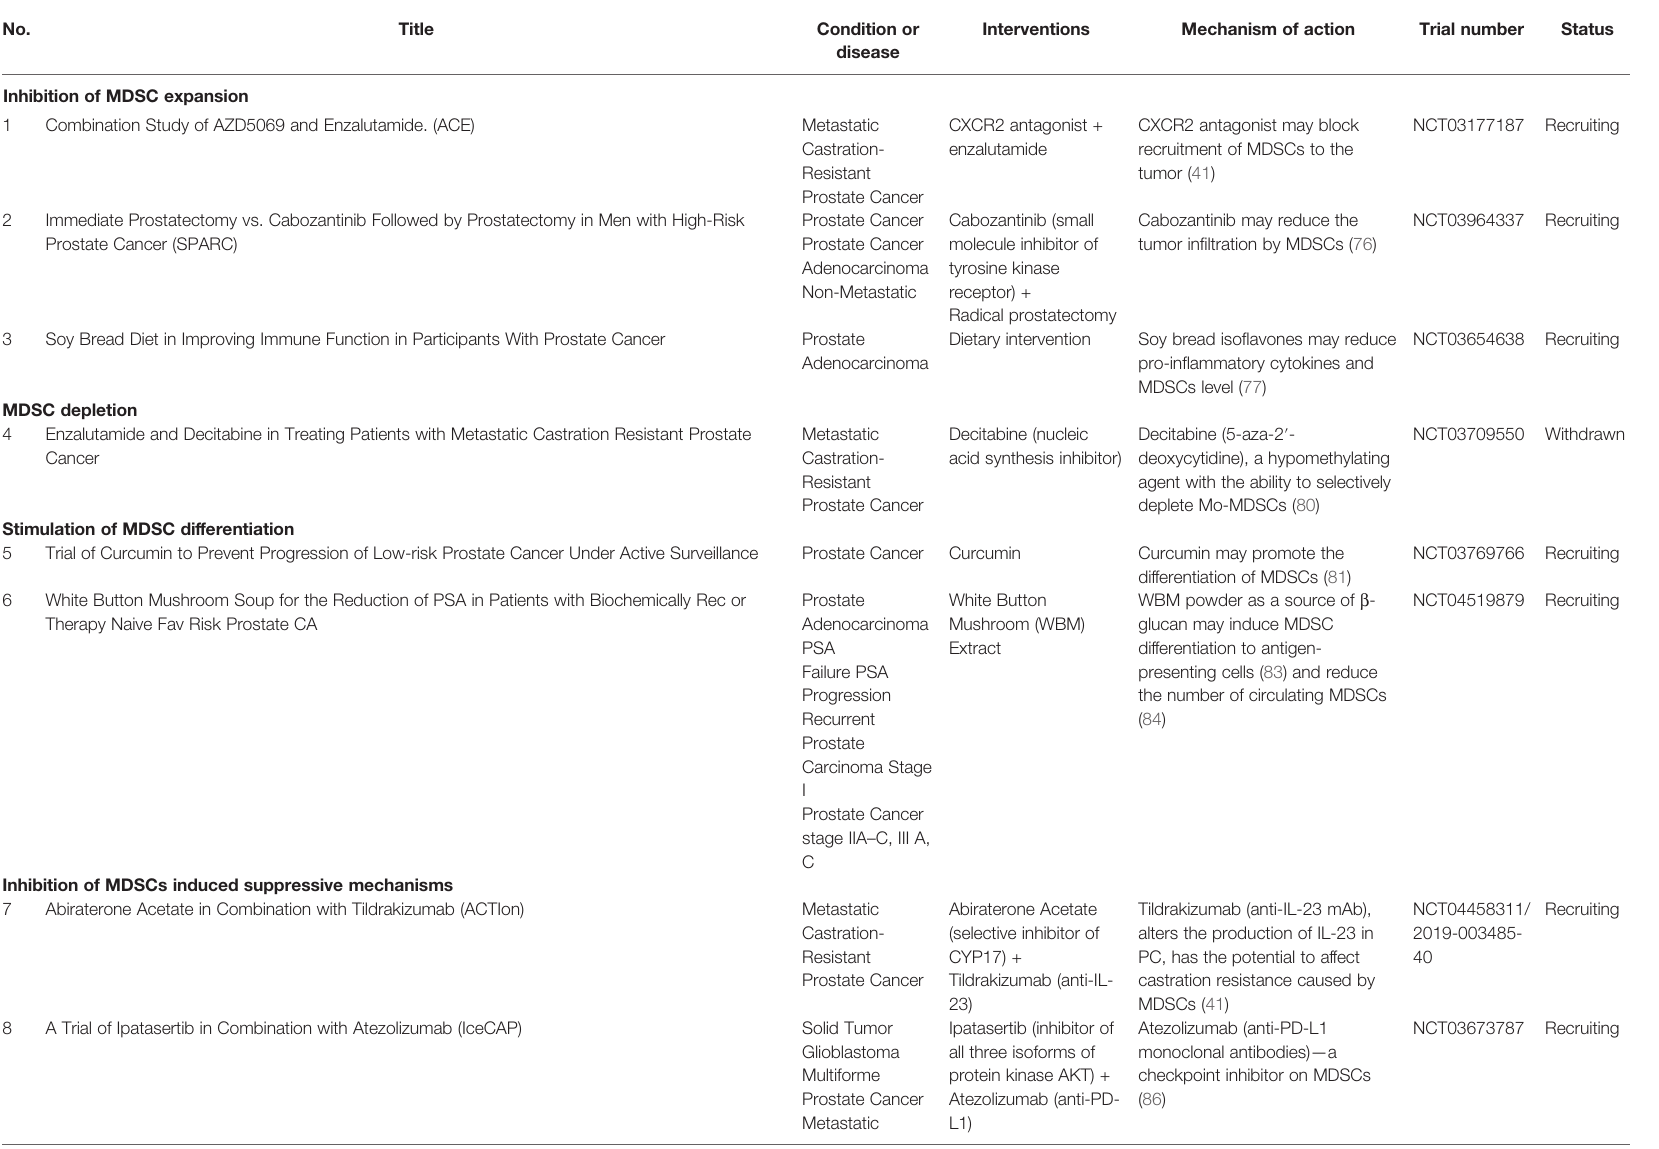
TABLE 1 | Clinical trials targeting MDSCs in PC